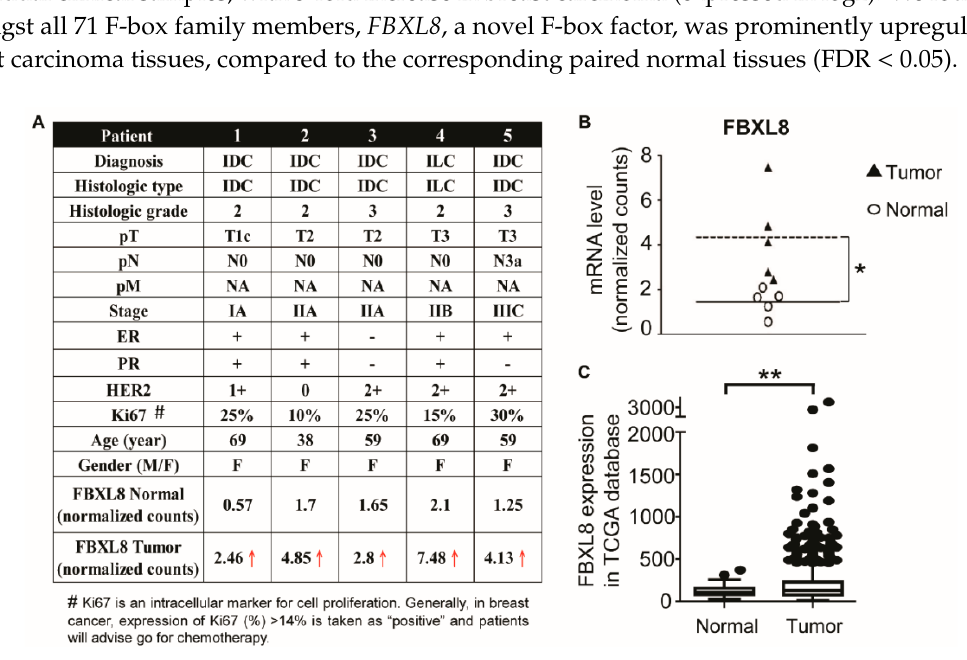
Figure 1. Cont Figure 1 . Cont.